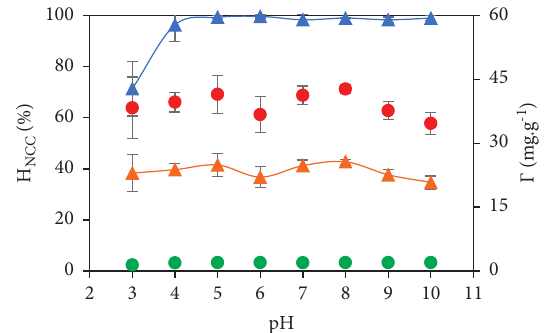
Figure 7: pH effect on the NCC adsorption onto the PVBTAC- modified α -Al 2 O 3 particles at pH 8, NaCl 10mM, t of 2h and different conditions as C i ,NCC of 10ppm, m α -Al2O3 of 3mg mL − 1 : ( ) H NCC (blue grid line) and ( ) Γ NCC (points); and C i ,NCC of 100ppm, m α -Al2O3 of 1mg mL − 1 : ( ) H NCC (orange grid line) and ( ) Γ NCC (points).